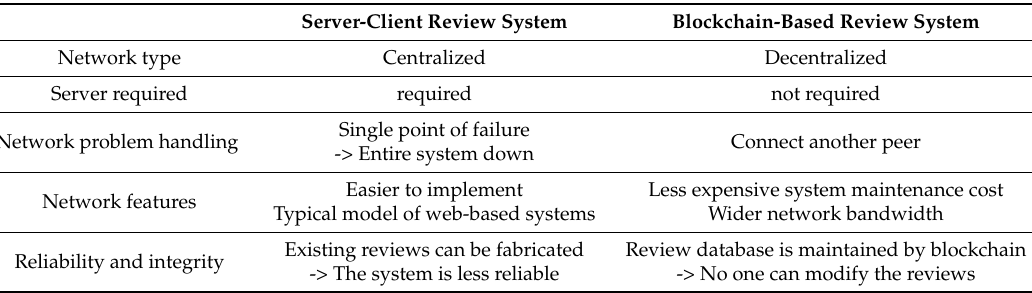
Table 1. Comparison of the centralized model with decentralized